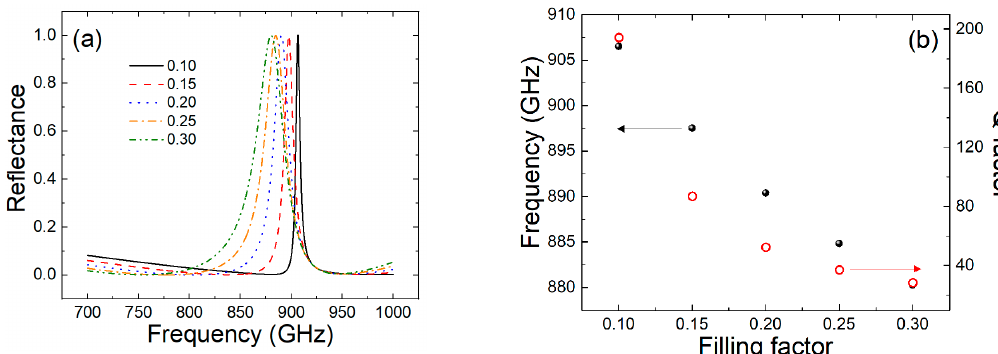
Figure 3. ( a ) Scheme of the simulated THz reflectance with size dependency of the grating layer, where n eff = 2.05; ( b ) peak frequency and Q-factor for the rectangular pattern.